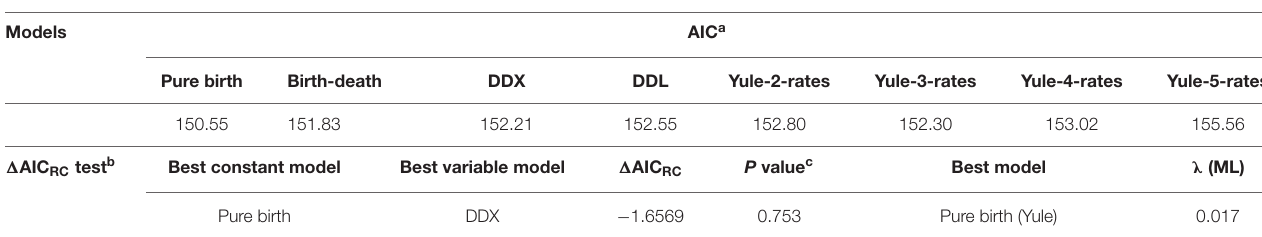
TABLE 2 | Diversification